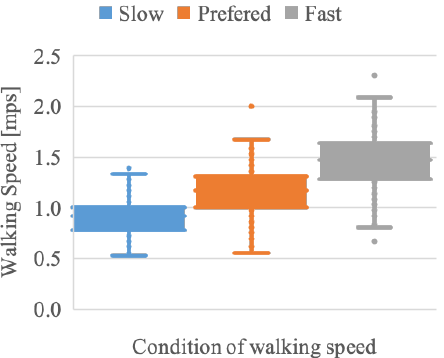
Figure 6. Results of data distribution under the condition of three different walking speeds: slow walking, preferred condition, and fast